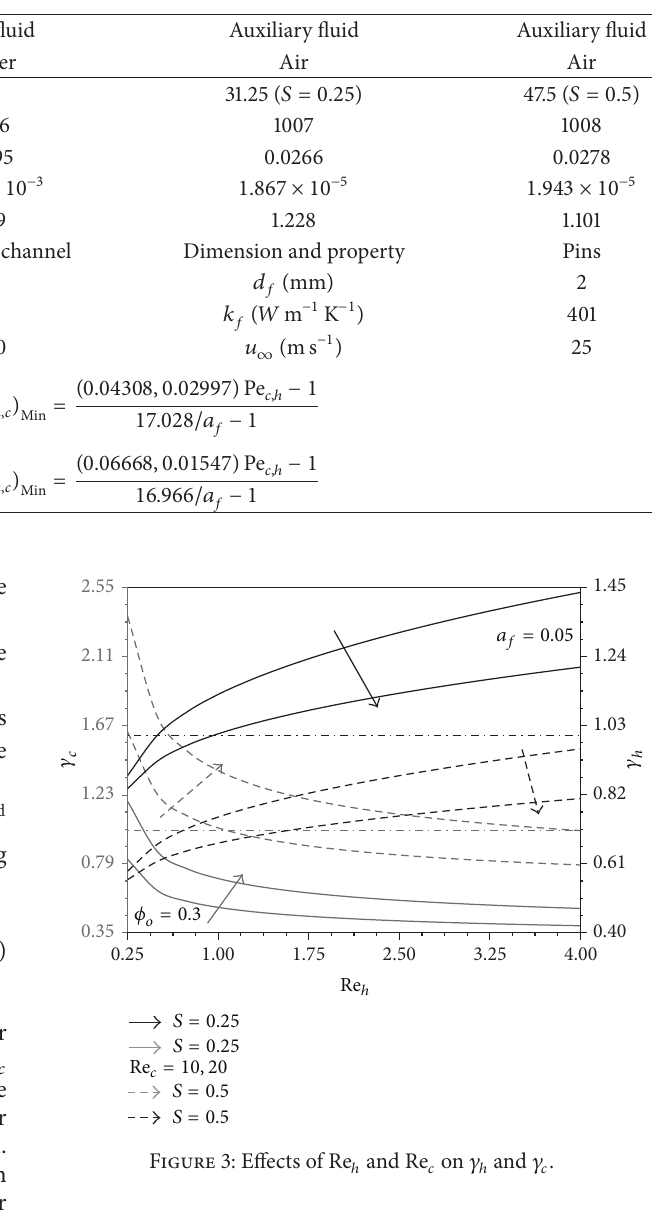
Table 1: The used fixed dimensions and the properties of different substances.